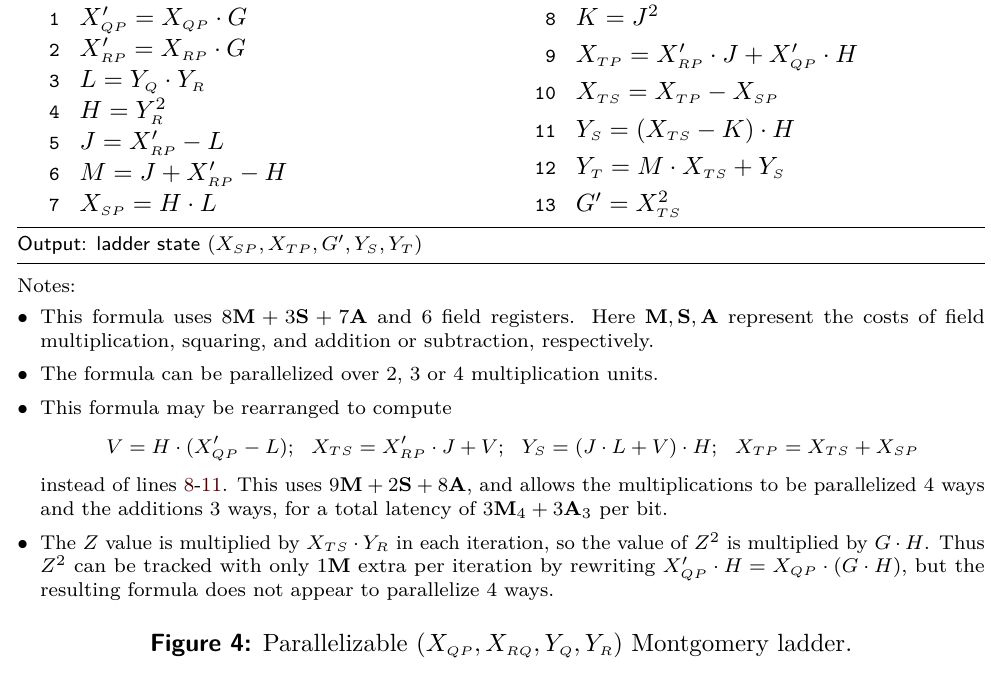
Figure 4: Parallelizable ( X